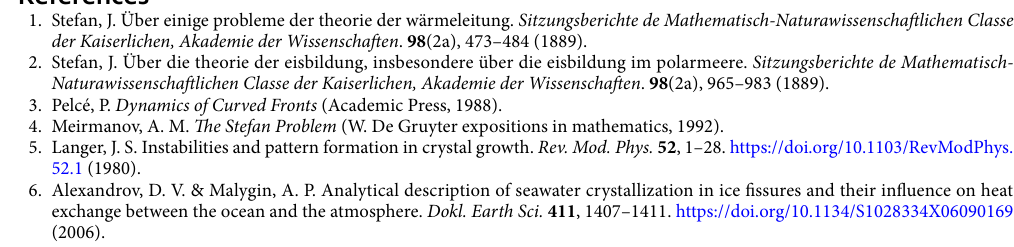
Figure 4. Dimensionless particle-size distribution function F ( s ) at different dimensionless coordinates z in the two-phase layer z 1 1.694 10 4 Z = ×